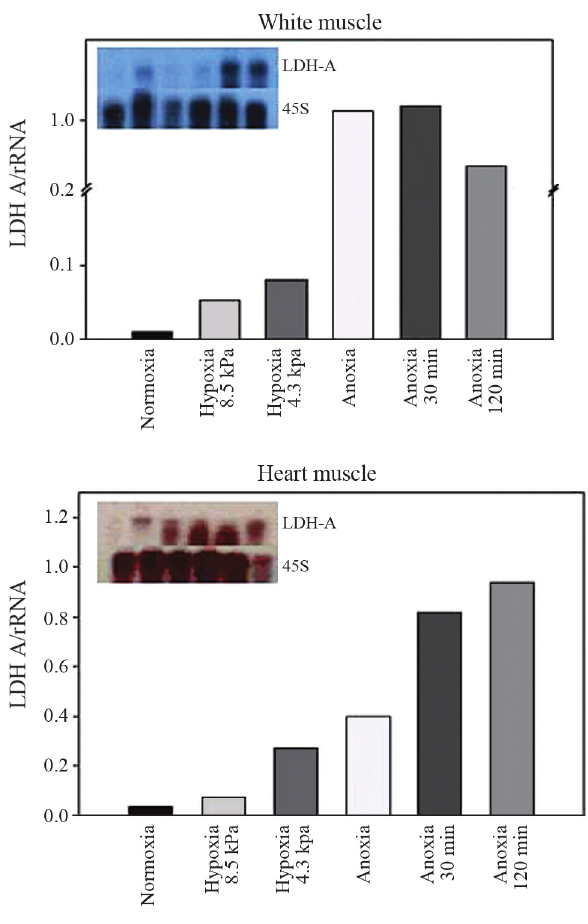
Figure 1 - Autoradiography and estimated relative expression of RNA in whitemuscle(top)andinheart(bottom)ofjuvenile Astronotuscrassipinis under different oxygen levels and hybridized with LDH-A and rRNA probes.Fishwereexposedtonormoxia,hypoxia(8.5kPaand4.2kPa)and anoxia (0.0